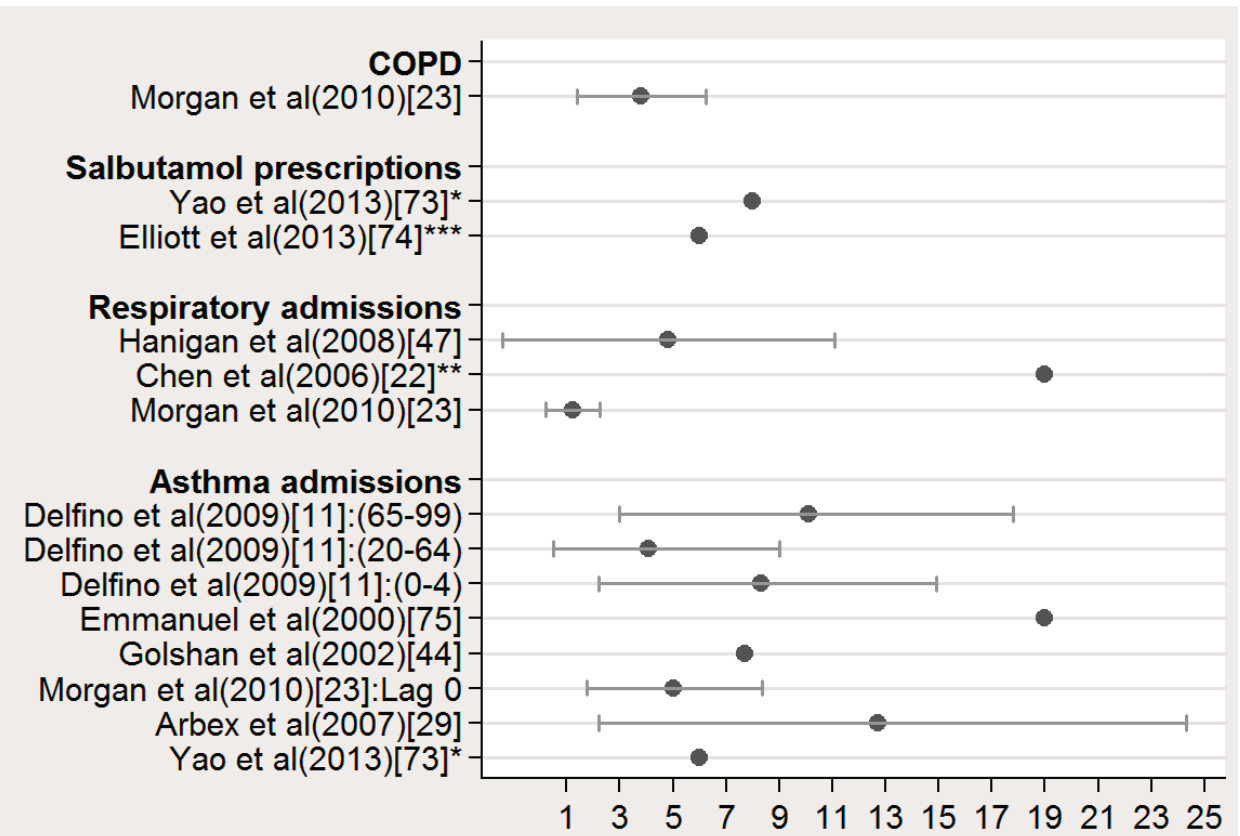
Figure 2. % increase 1 of respiratory morbidity outcomes as discussed in the literature per various increases in particle matter (PM) (Mean rate and 95%